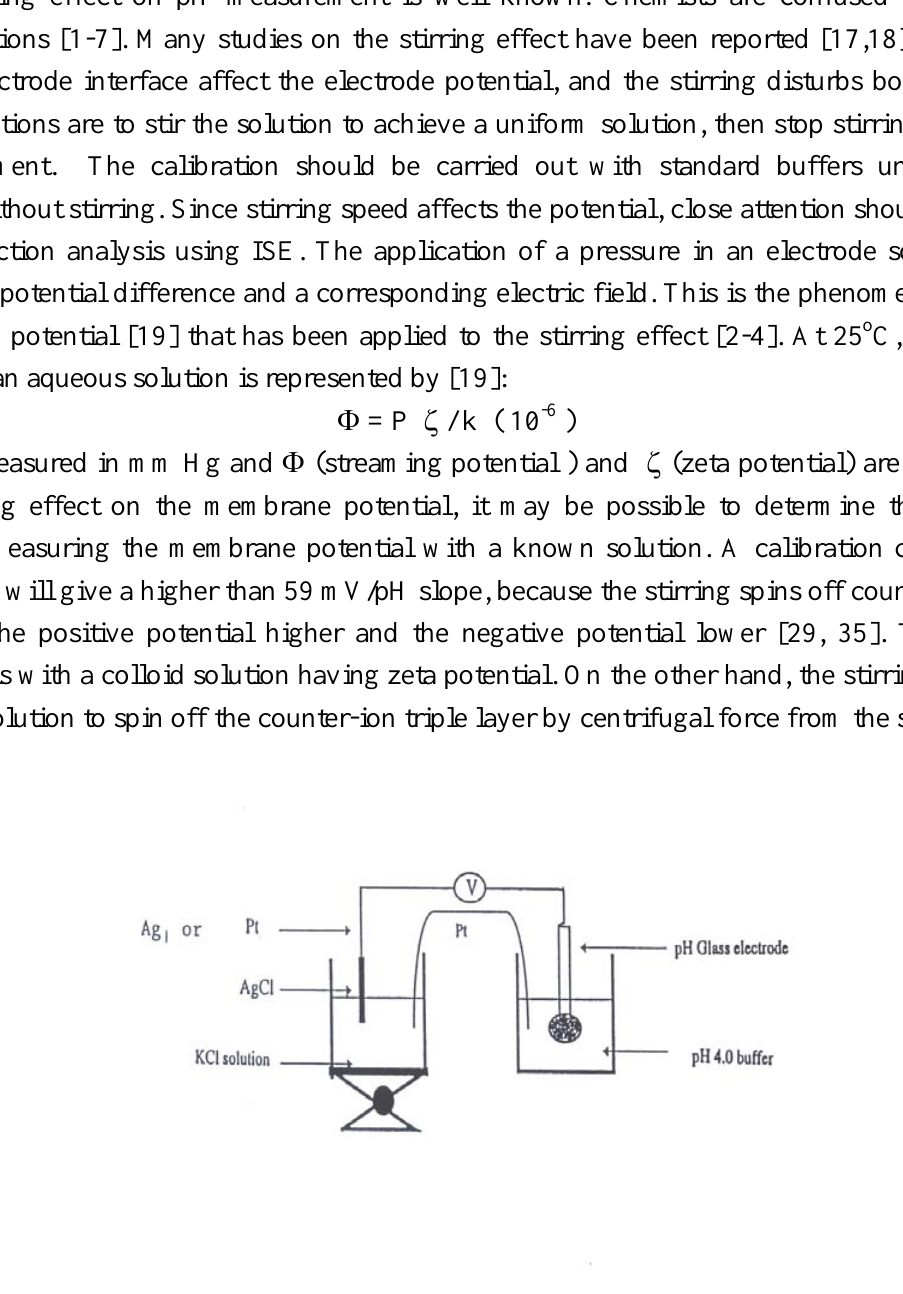
Figure 4. Experimental set up. Ag/AgCl or Pt/AgCl electrode is dipped progressively in a solution of KCl. Potentials are measured against a constant pH glass